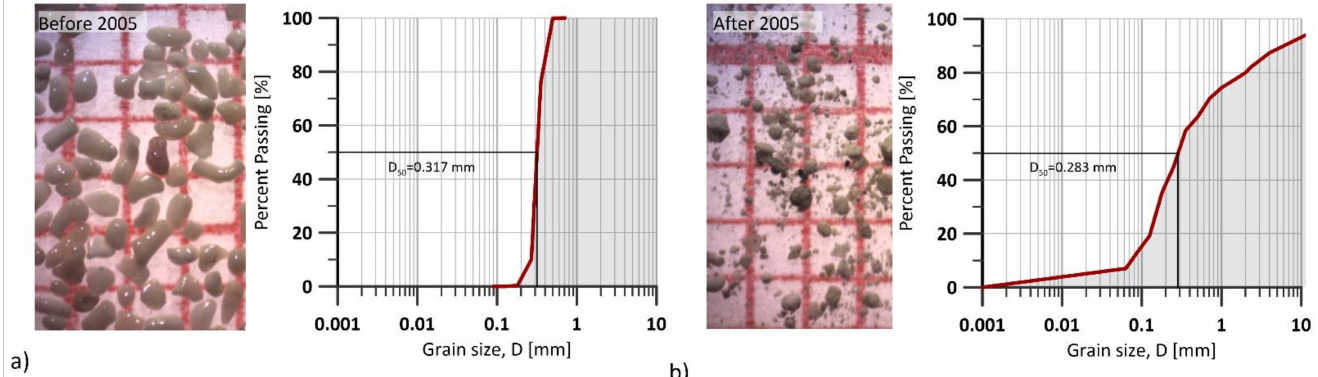
Figure 2. Cumulative grain size distribution and microscope images (1 mm grid) of sand samples at Cancun (21.172913 ◦ N, 86.805336 ◦ W) ( a ) before and ( b ) after the 2005 beach nourishments in that area following hurricane Wilma.